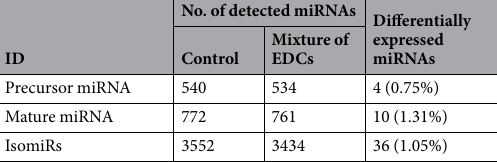
Table 1. Global analysis of miRNAs population in testes of control mice and EDCs mixture-exposed mice. The boxes display the number of different sequences found with sncRNA-Seq designed from RNA libraries of pools of control and exposed mouse testes (n = 3). The final row displays the number (percentage) of differentially expressed miRNA: miRNA-precursors, canonical miRNA, and isomiRs